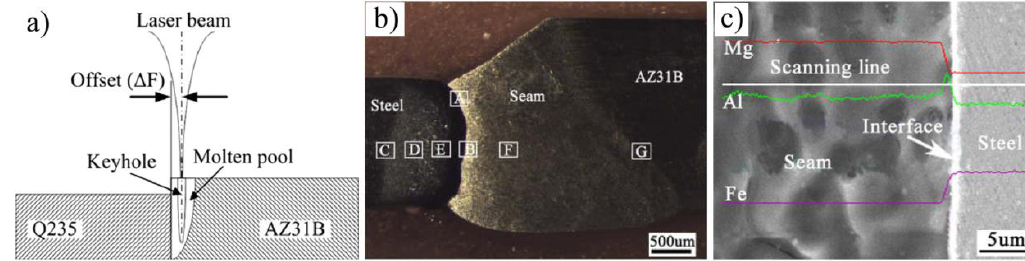
Figure 9. Laser penetration welding-brazing [32] ( a ) schematic diagram; ( b ) cross-section of butt joint; ( c ) interface characteristics of the lower part of joint and element distributions.